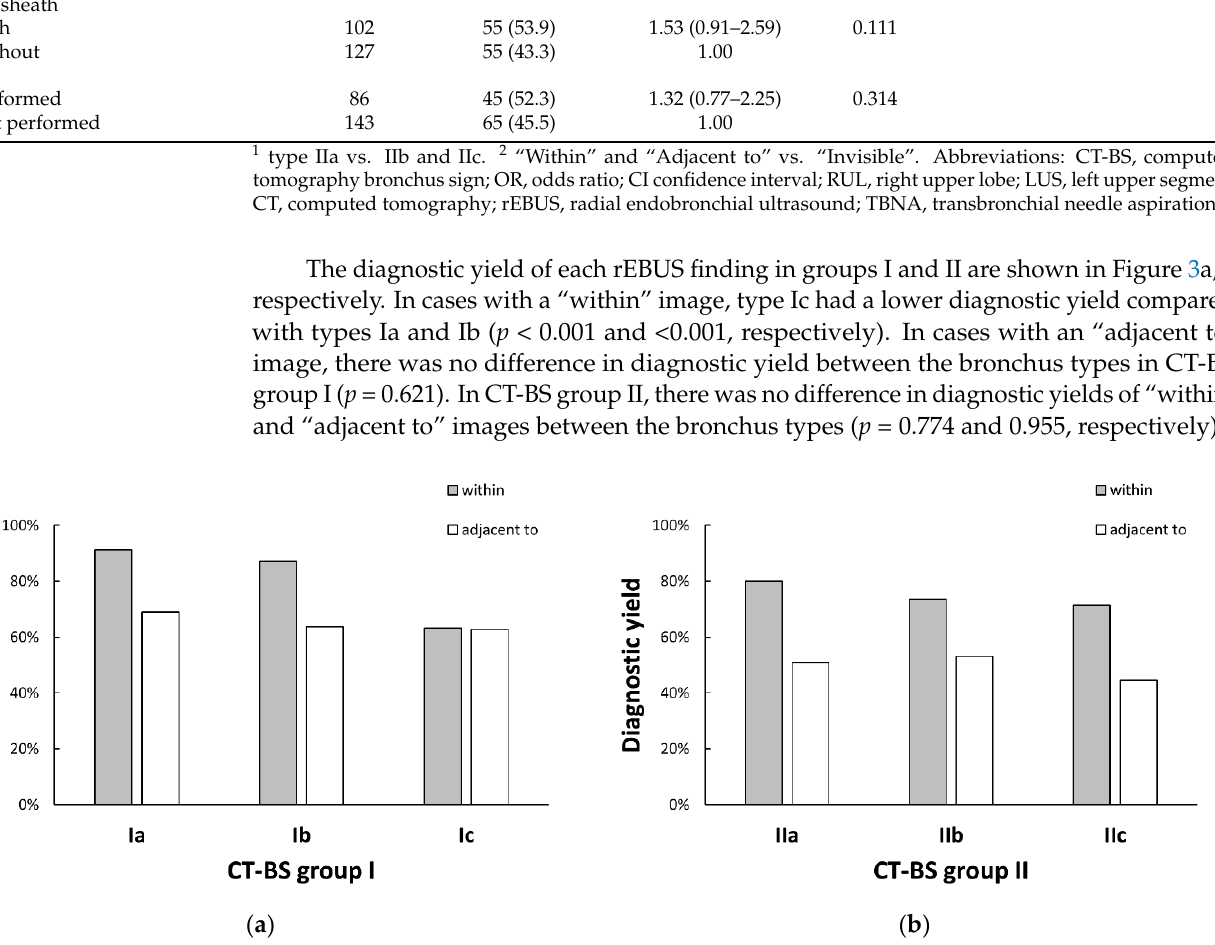
Figure 3. Diagnostic yields of each rEBUS finding in CT-BS groups ( a ) I and ( b ) II. In cases with a “within” image, type Ic had a lower diagnostic yield compared with types Ia and Ib ( p < 0.001 and <0.001, respectively). In cases with an “adjacent to” image, there was no difference in diagnostic yield between the bronchus types in CT-BS group I ( p = 0.621). In CT-BS group II, there was no difference in diagnostic yields of “within” and “adjacent to” images between the bronchus types ( p = 0.774 and 0.955, respectively). rEBUS, radial endobronchial ultrasound; CT-BS, computed tomography bronchus sign.